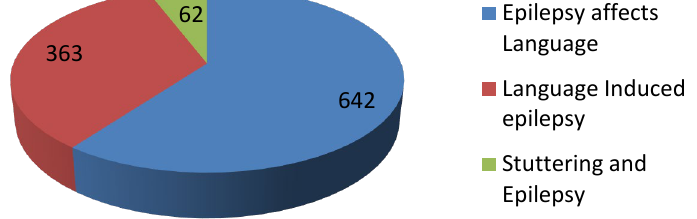
Figure 2. Number of published articles per topic